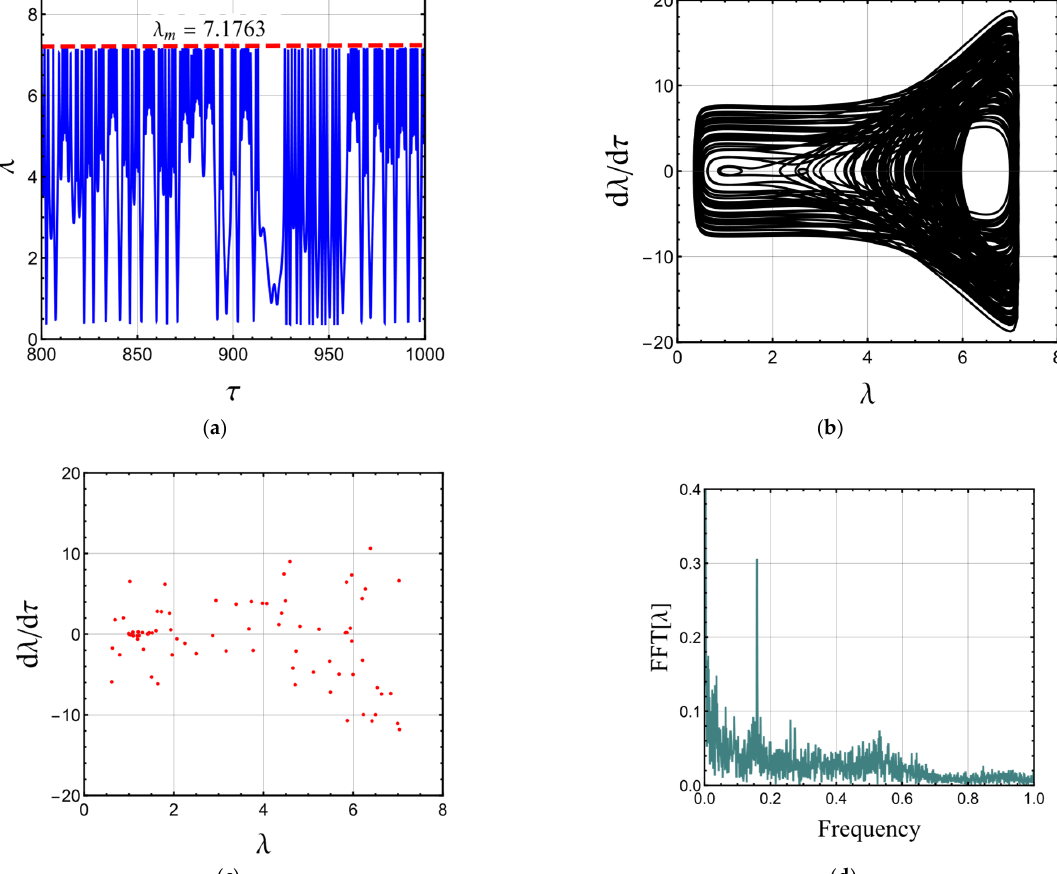
Figure 6. The dynamic response of the electro-magneto-active polymer to time-varying voltage 𝐻(cid:3365) (cid:2903) (cid:3404) 0.4 . ( a ) Time history, ( b ) phase plane diagram, ( c ) Poincaré map, and ( d ) FFT.